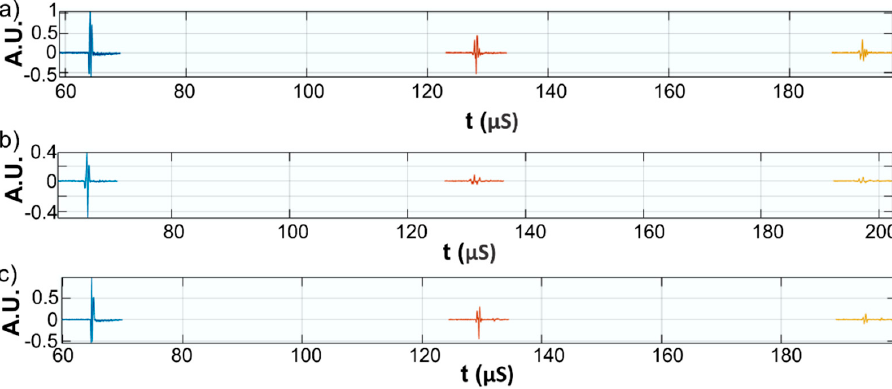
Figure 9. Acquired signals for: Wi ( a ); WZn ( b ); and Wd ( c ).